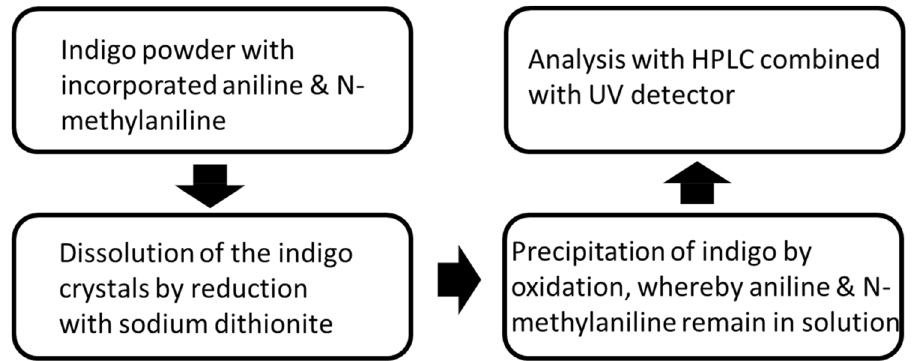
Figure 3. The basic procedure for the analysis of aniline and N-methylaniline in indigo with